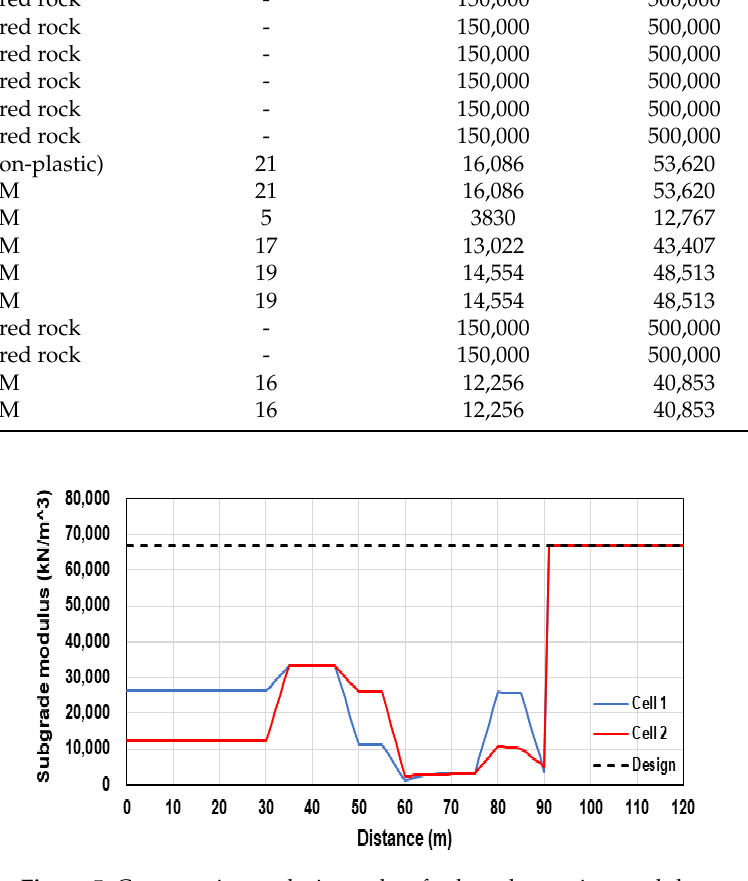
Figure 5. Comparative analysis results of subgrade reaction modulus.